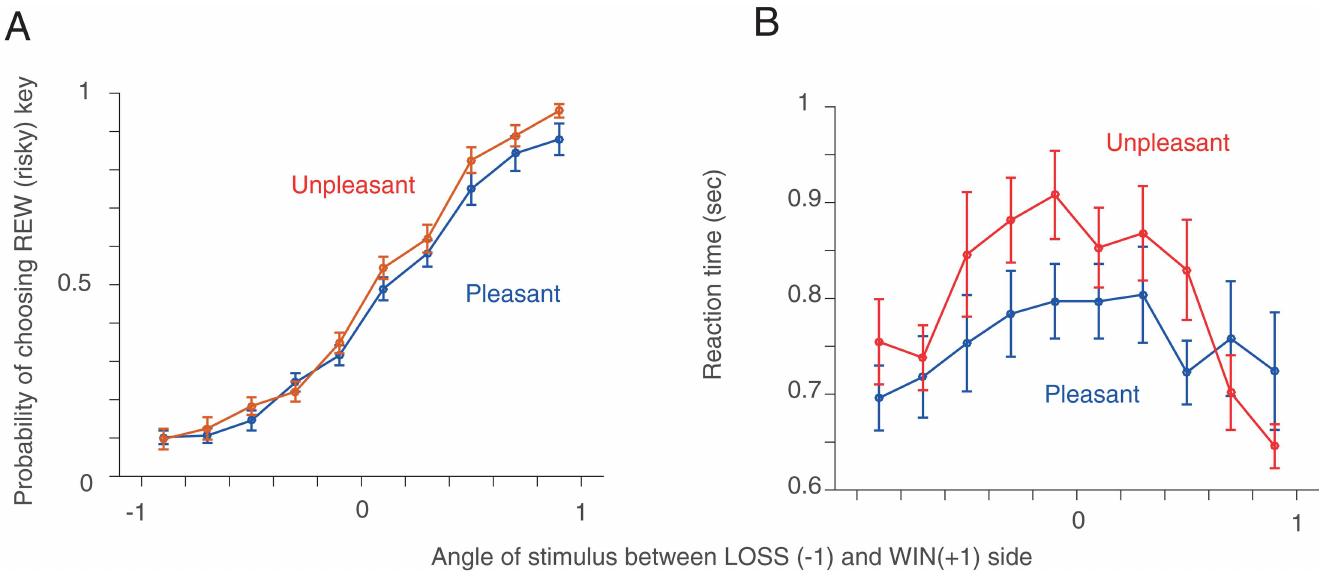
Fig 4. Model-agnostic results (Session 3). A . The probabilityof choosingthe REW (risky) key in Session 3. The red (blue) line indicates the mean and the SEM of participants in the Unpleasant (Pleasant) condition. B . Reaction time (RT). Note that this session has 250 different stimulus ambiguities for each participants. We binnedconditionswith the width of s =